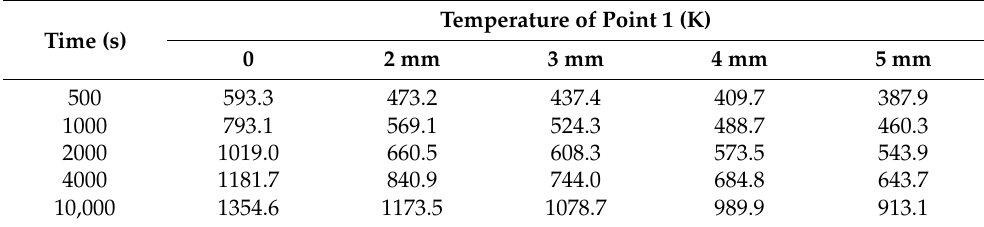
Figure 15. Temperature variation over time with different initial thicknesses. Table 6. Temperature with different initial thicknesses at different times.